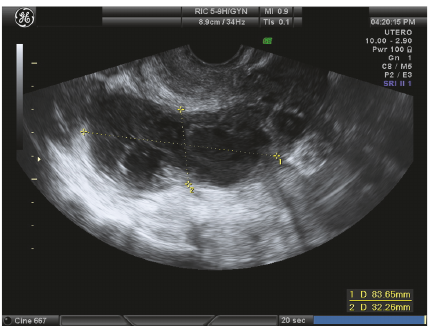
Figure 1: Case one: right adnexal